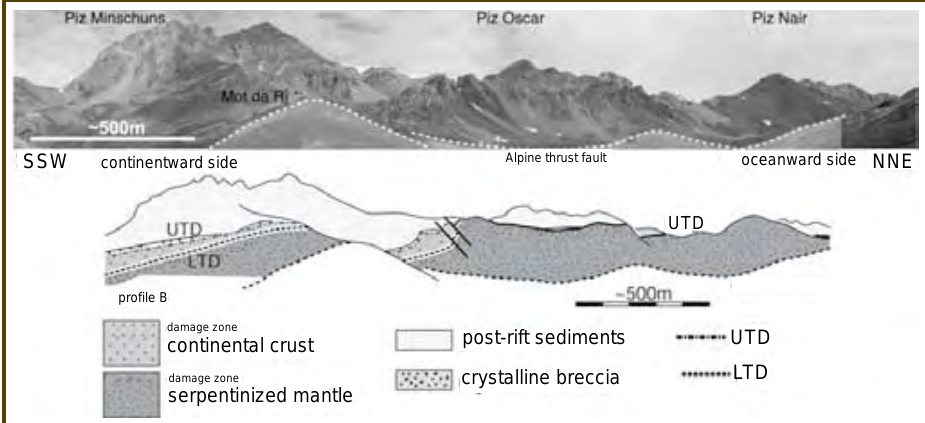
Figure 13. Exposed continent-ocean transition in the Tasna nappe in southeastern Switzerland (after Florineth View of the ocean-continent transition exposed in the Tasna nappe in Grisons, SE Switzerland and Froitzheim, 1994). Onshore analogs have contributed significantly to understanding hyper-extended margin (modified after Florineth and Froitzheim 1994). UTD: Upper Tasna detachment; LTD: Lower Tasna development. UTD: Upper Tasna detachment; LTD: Lower Tasna detachment.